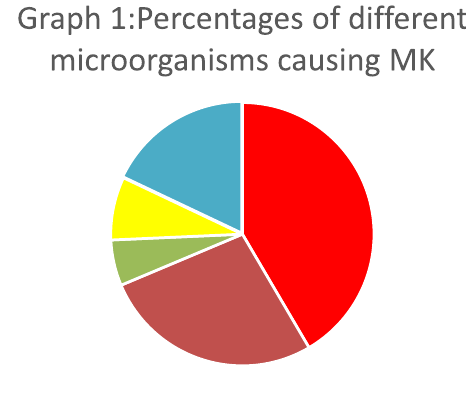
Fig. 6 The percentage of distribution of the different microorganisms causing MK